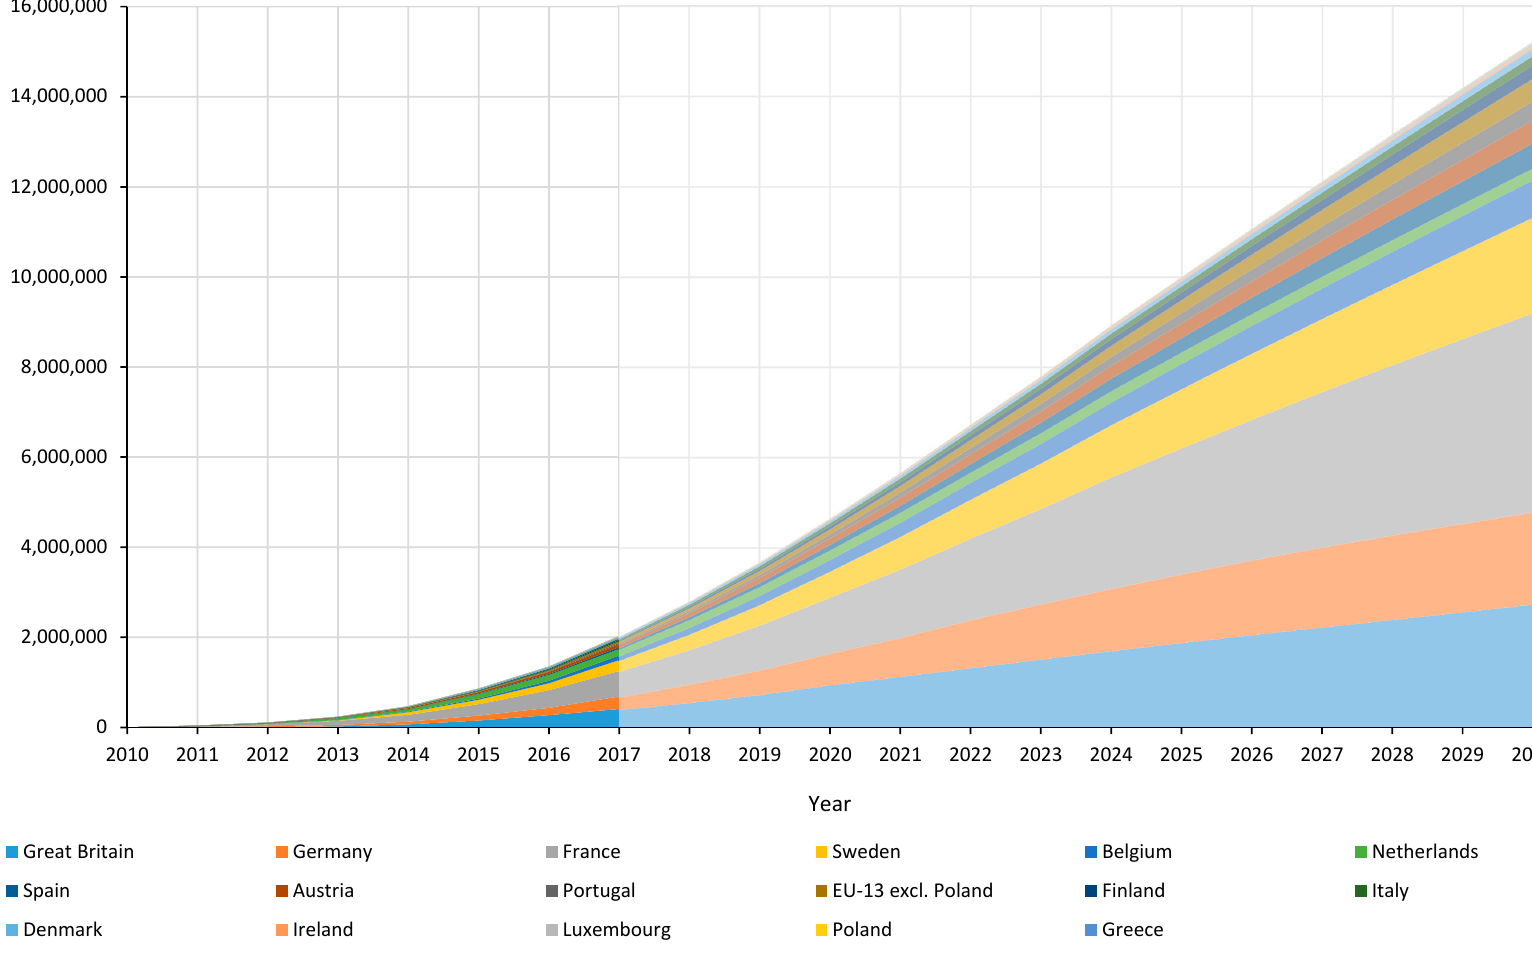
Figure 9. Comparison of cumulative emission reductions (after correction) for the European Union countries in the years 2010–2017 together with the forecast by 2030.